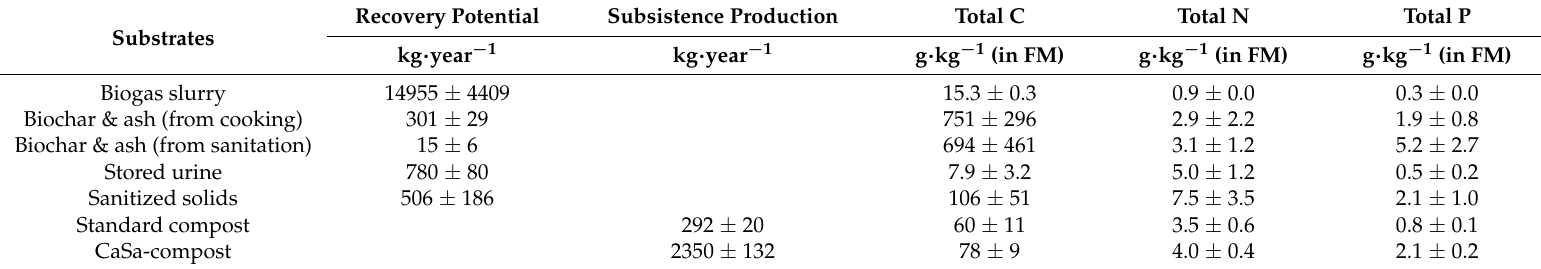
Table 2. Quantities and qualities of the organic, organo-mineral, and mineral inputs used in the IPNM strategies